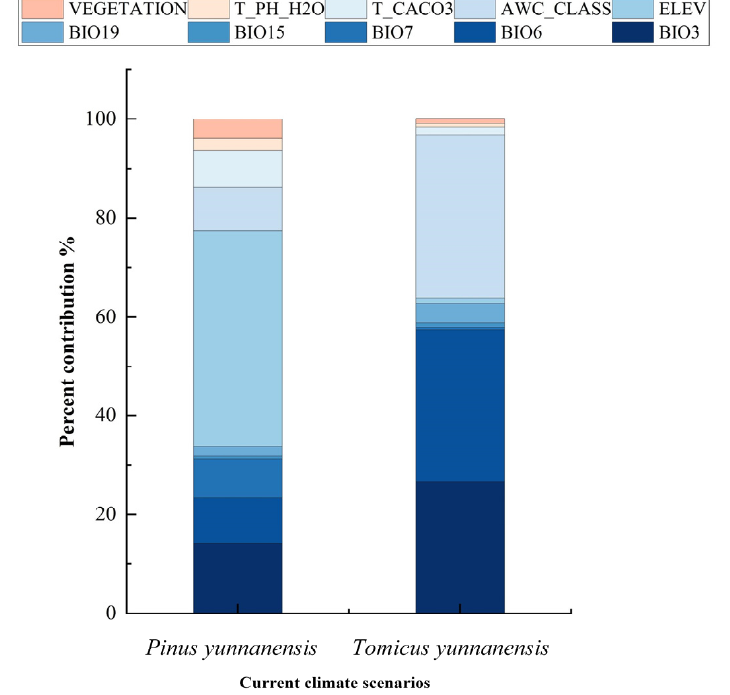
Figure 3. Percentage of environmental factors of P. yunnanensis and T. yunnanensis.